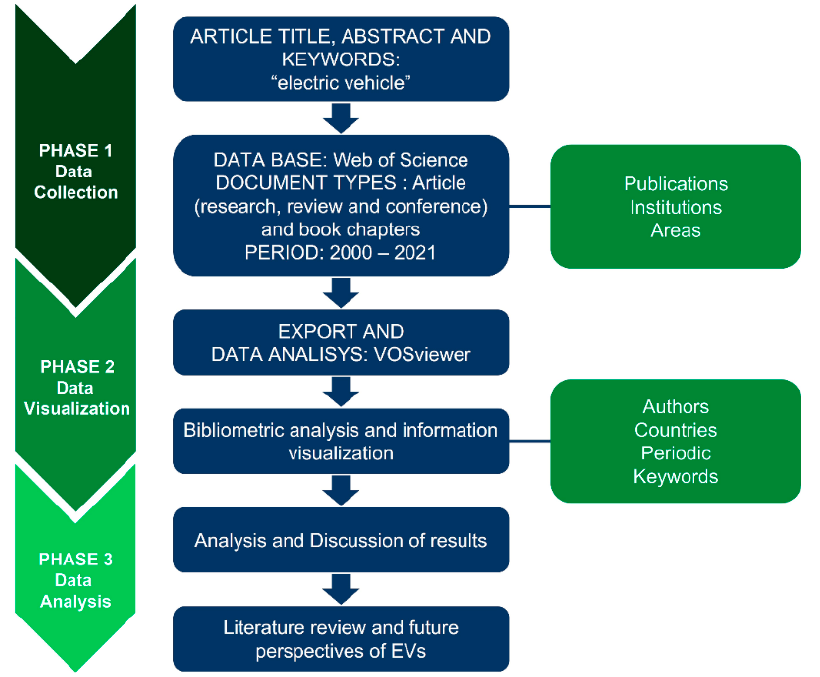
Figure 1. Methodology phases and their main steps and analyzed criteria applied to the present work.